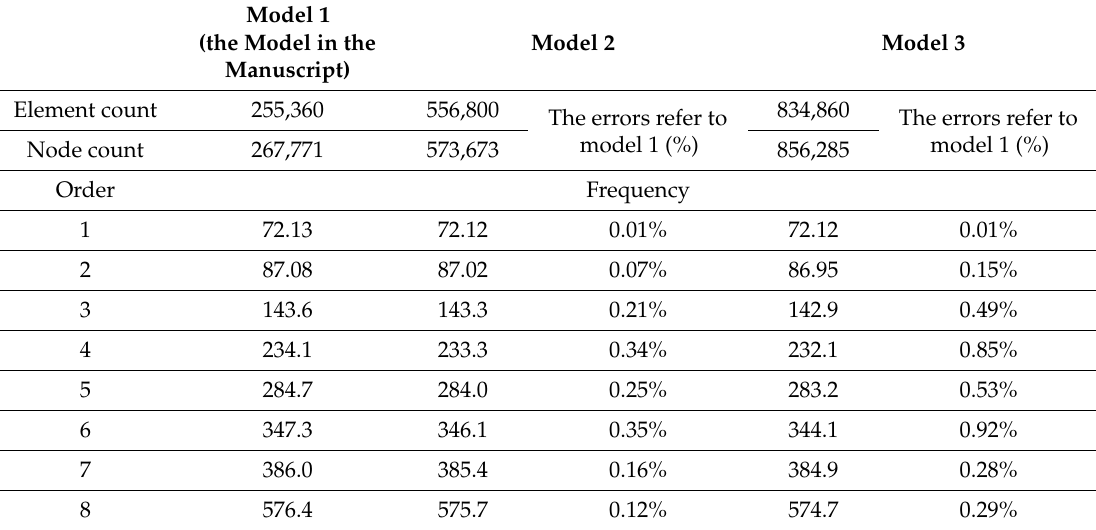
Table A2. The comparison results of modal